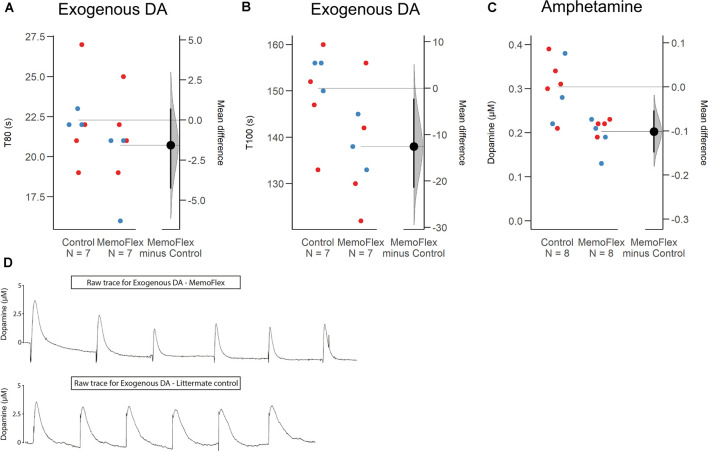
Clearance of exogenous dopamine (DA) and amphetamine-induced release of DA in the dorsal striatum of MemoFlex mice and littermate controls. (A,B) Mean values of T80 and T100 obtained from six consecutive ejections of exogenous DA. Male: blue; Female: red. (C) Mean values of DA released by three amphetamine ejections. (D) Raw traces of exogenous DA in MemoFlex (top) and control mice (bottom). *p < 0.05, **p < 0.01, as detected by two-tailed Student’s t-test, expressed as mean ± SEM. MemoFlex: n = 7, four females, three males; controls: n = 7, four females, three males.